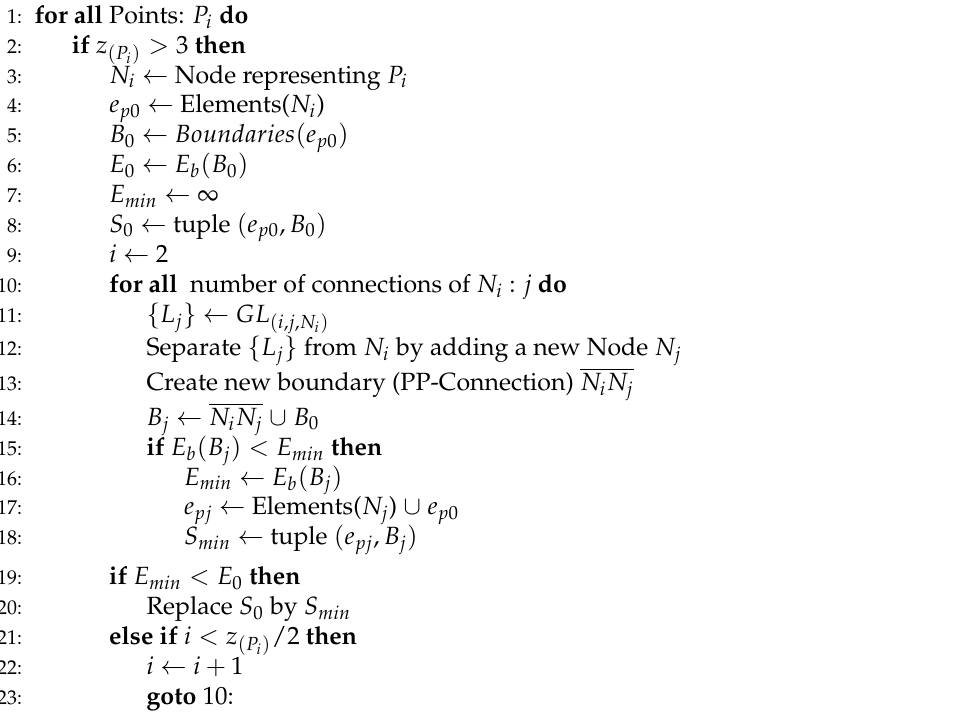
Algorithm 1 MJ decomposition algorithm for the TRM model